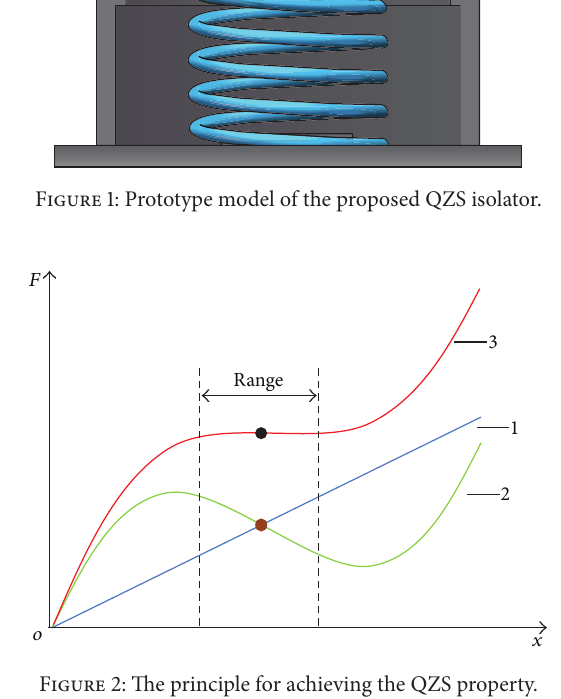
Figure 2: The principle for achieving the QZS property.